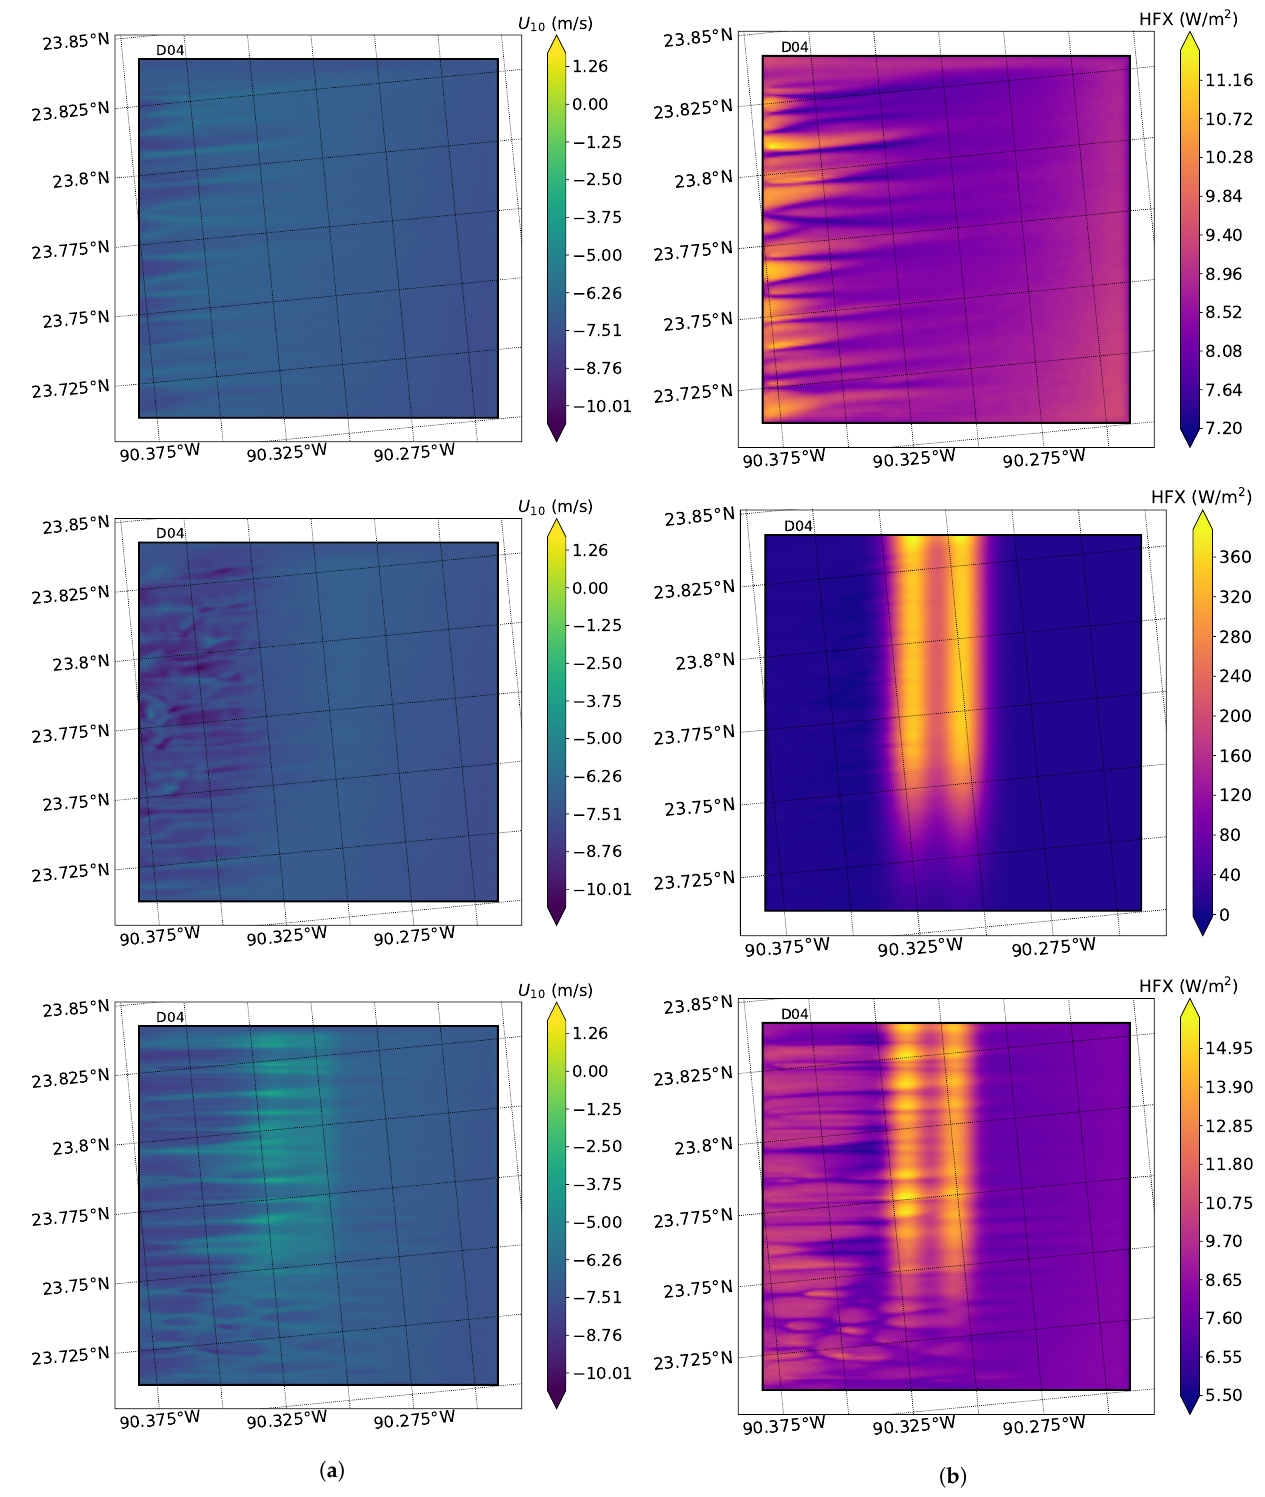
Figure 3. Predicted contours of ( a ) 10 m U -wind and ( b ) Upward heat flux. The top row contains predictions for the baseline case, the middle row contains predictions for SST-only modifications, and bottom most row shows predictions for sea surface current-only